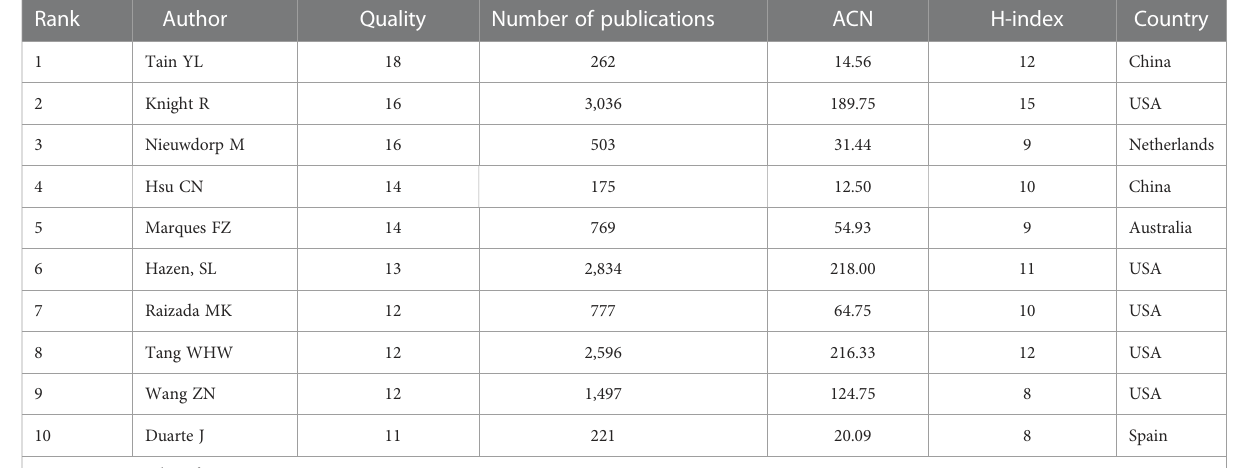
TABLE 2 The top 10 authors of GM in CVD.